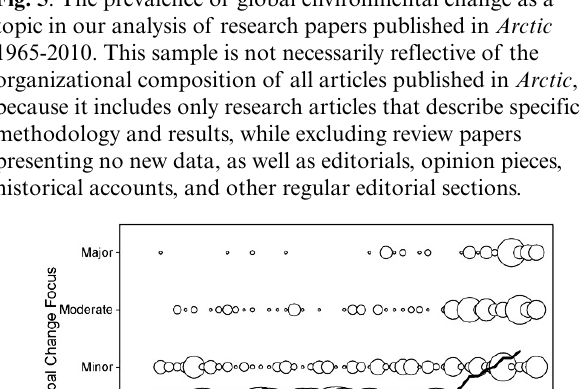
Fig. 5 . The prevalence of global environmental change as